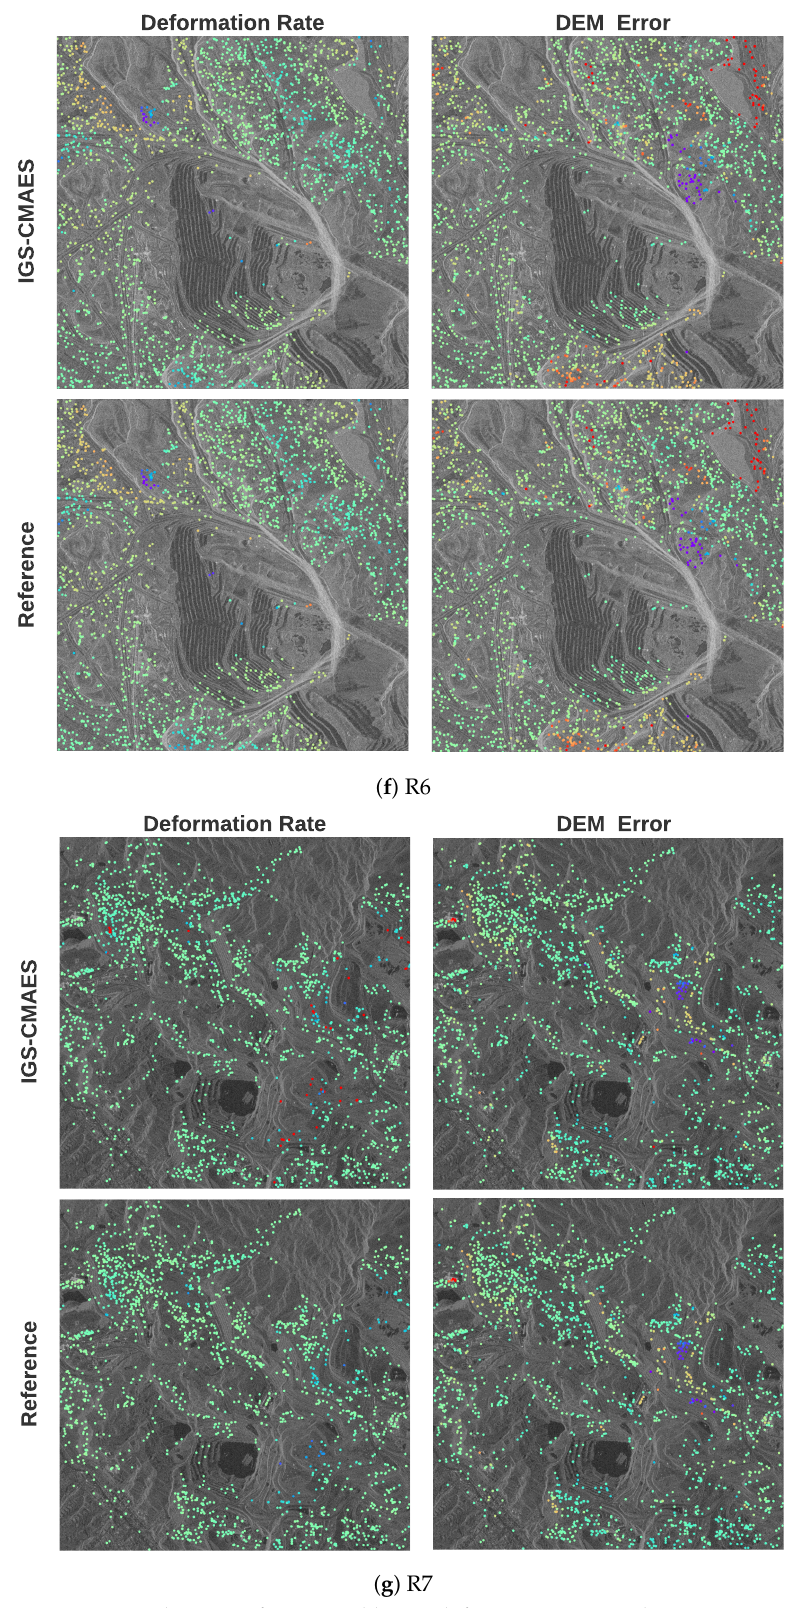
Figure 8. Visualization of estimated linear deformation rate and DEM on R1–R7 real-world stack’s PS pixels. IGS-CMAES is applied on wrapped interferogram directly. Reference results are generated using 3vGeomatics processing pipeline with unwrapped